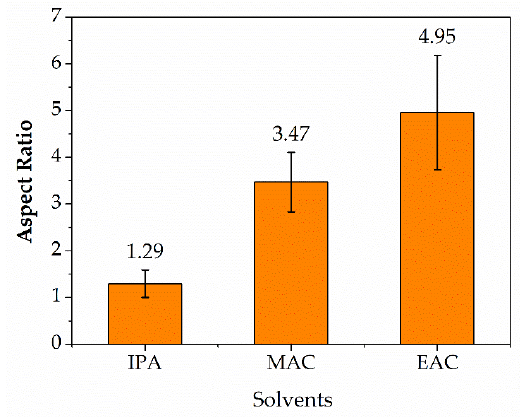
Figure 5. The aspect ratios of the catechol crystals obtained from solvents.